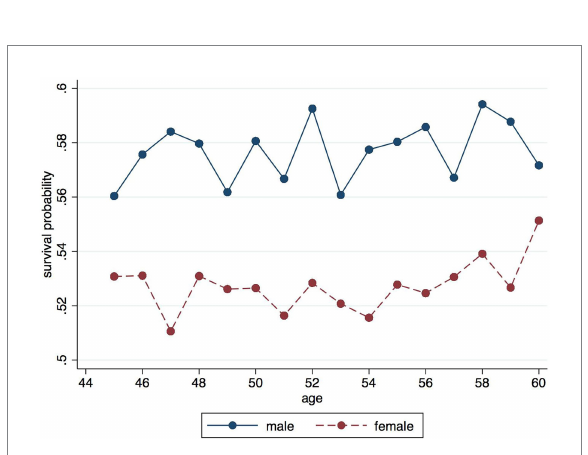
FIGURE 3 Comparison of subjective life expectancy by